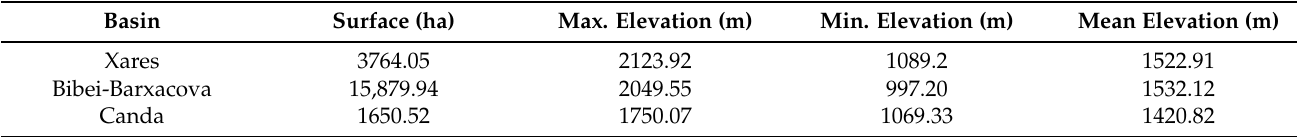
Table 1. Palobasins characteristics. Their extension is in Figure